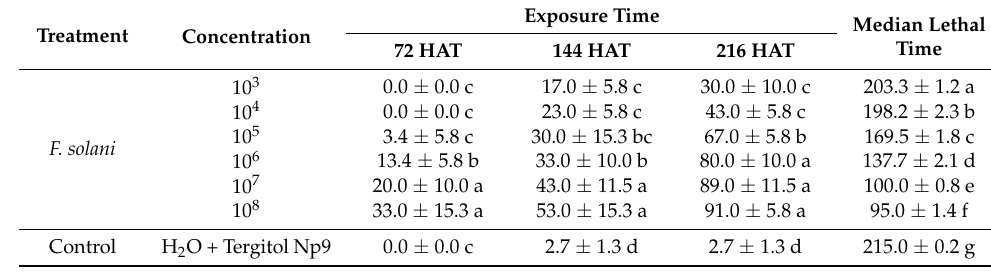
Control mortality (H 2 O + Tergitol NP9 0.05%) was 2.7% at the end of the experiment. By contrast, fungus F. solani resulted in varying degrees of larval mortality, which was proportional to the concentration used (Table 3). Larval mortality ranged on the 9th day of the experiment between 30 to 91%. All applied doses differed significantly from the control, with the lower doses of 10 3 , 10 4 and 10 5 inducing 30 to 67% mortality by 9th day. In the doses of 10 6 , 10 7 and 10 8 the recorded mortalities were significantly higher compared with the control, in all cases. The main effects and interactions for all factors proved to be significant (Concentration: F = 2.107, df = 6, 1002, p < 0.001; Exposure Time: F = 4.031, df = Table 3. Mean mortality (± sd) and mean Median Lethal Time of H. armigera larvae exposed to F. solani for 216 h of two season experiment. Means of the same column followed by the same letter are not significantly different (Tukey test, a = 0.05), Median Lethal Time (hours ± sd) was estimated by the Kaplan–Meier method (F = 3.220, df = 6, p < 0.001), HAT: Hours After Treatment.